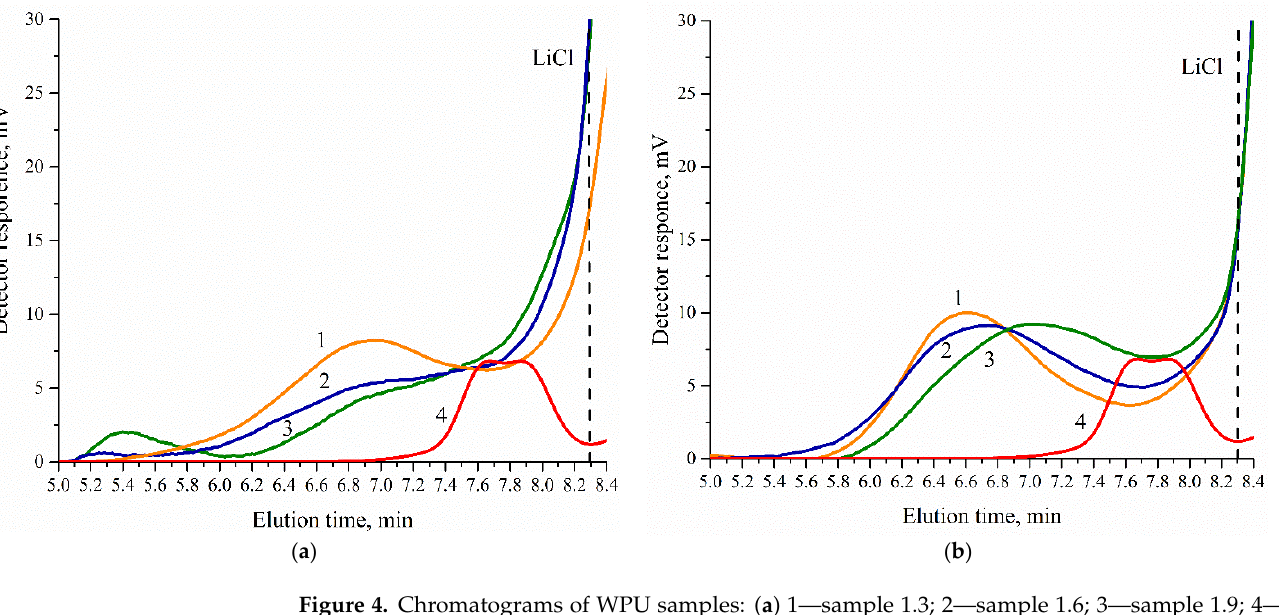
Figure 4. Chromatograms of WPU samples: ( a ) 1—sample 1.3; 2—sample 1.6; 3—sample 1.9; 4—CDPN; ( b ) 1—sample 2.3; 2—sample 2.6; 3—sample 2.9;